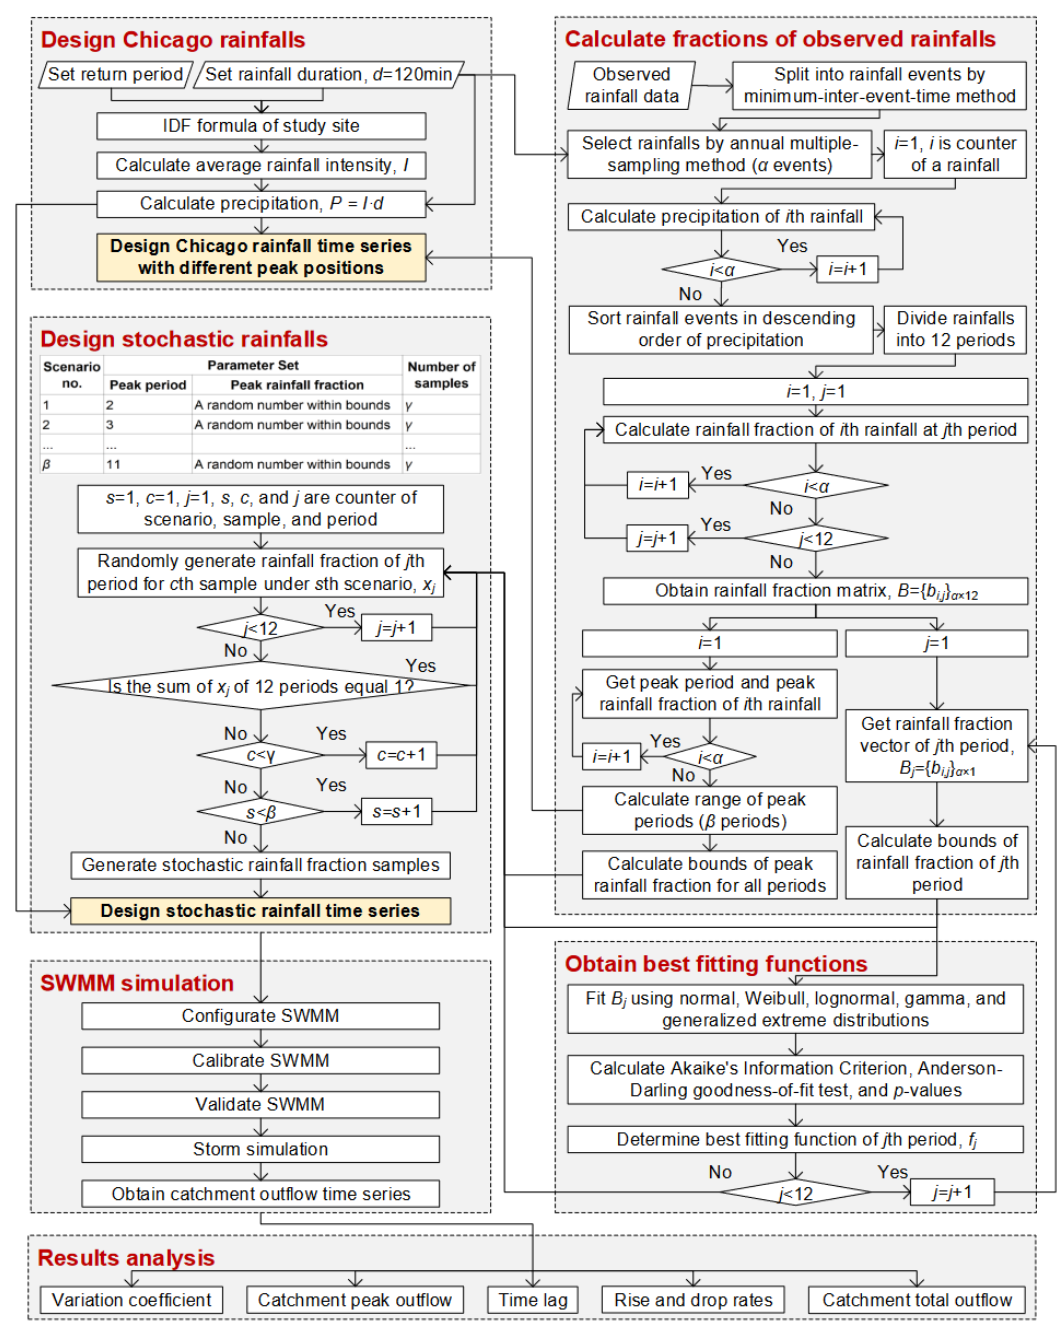
Figure 2. Event-based stochastic parametric rainfall simulator (ESPRS) framework and storm water management model